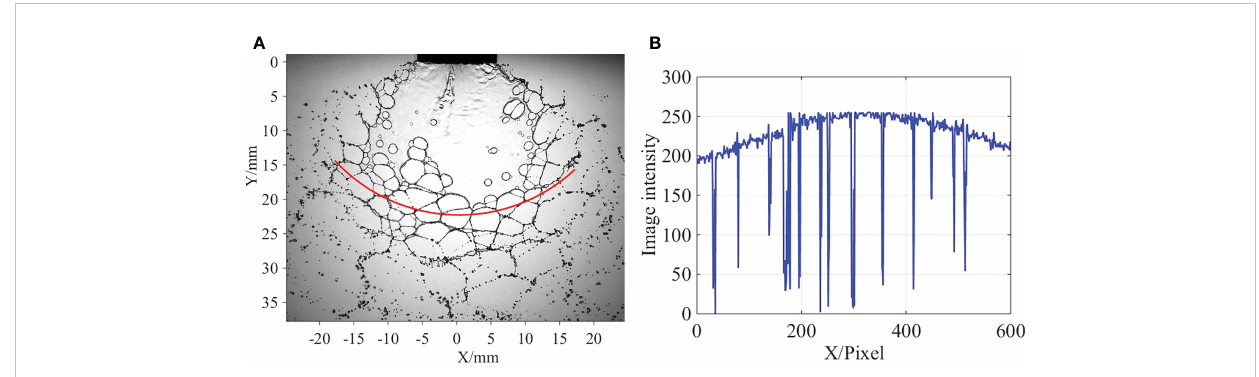
FIGURE 4 Measurement of perforation number in web structure. (A) Red line indicates the positions where image intensities of pixels were measured. (B) Variation of image